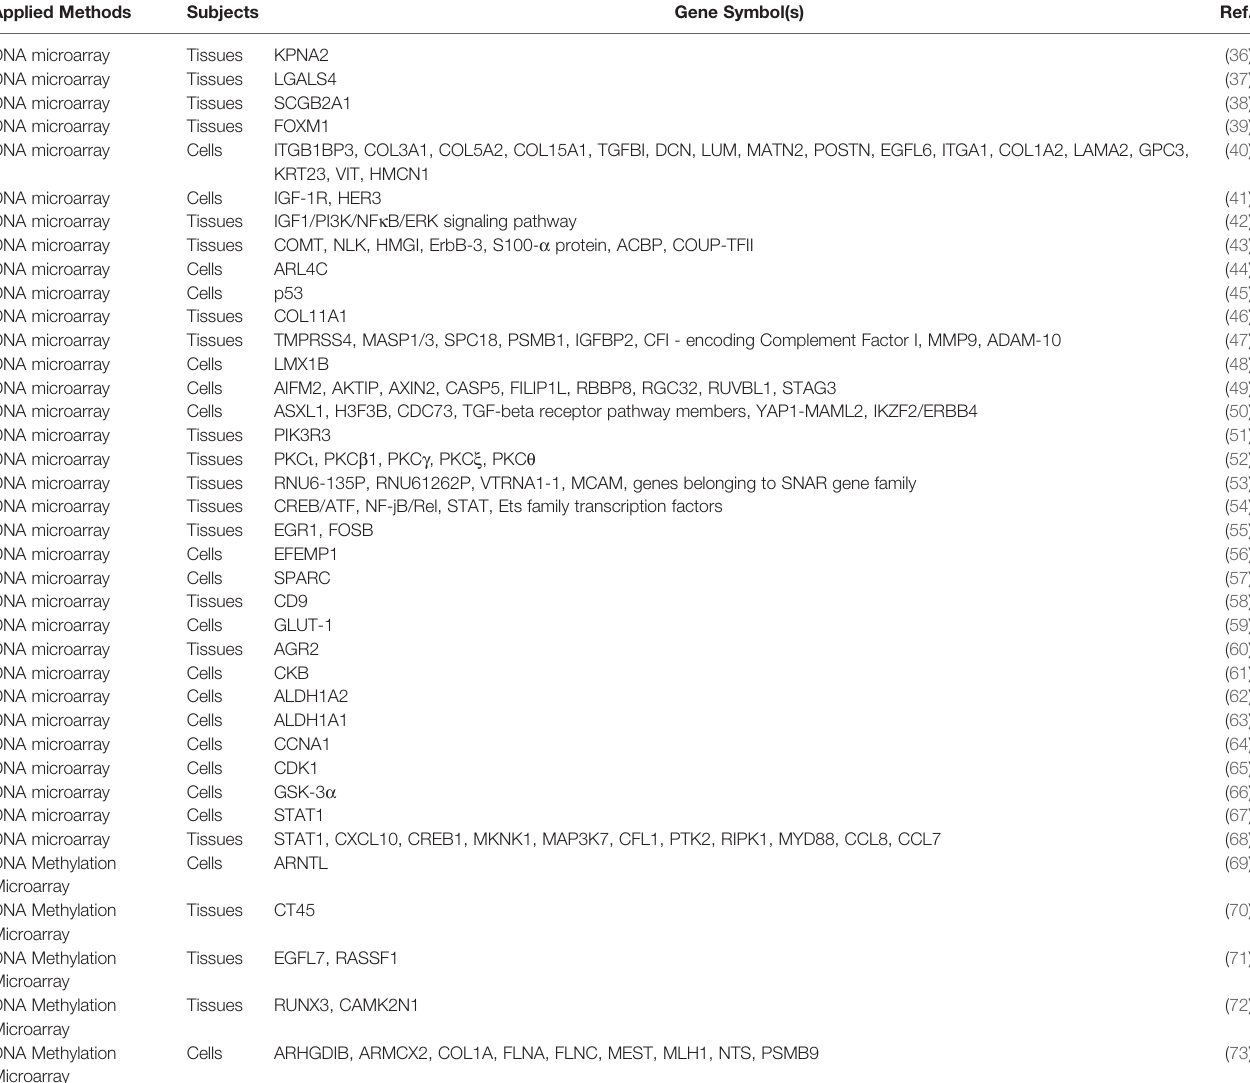
TABLE 1 | The application of genomics for exploring the candidate biomarkers for ovarian cancer. Applied Methods Subjects Gene Symbol(s)